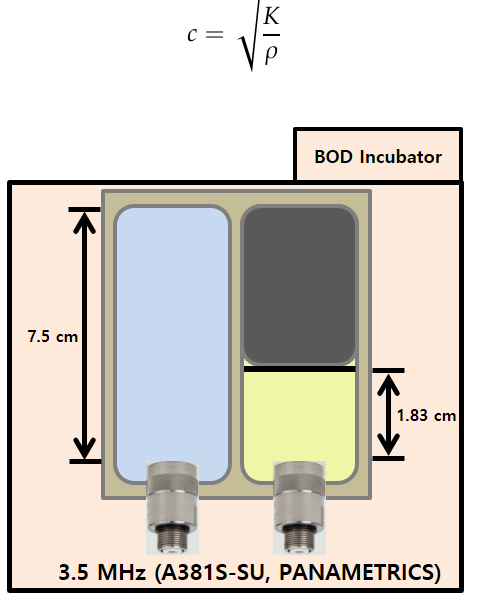
Figure 1. Acoustic measurement system to measure the sound speeds in water and castor oil (top view).